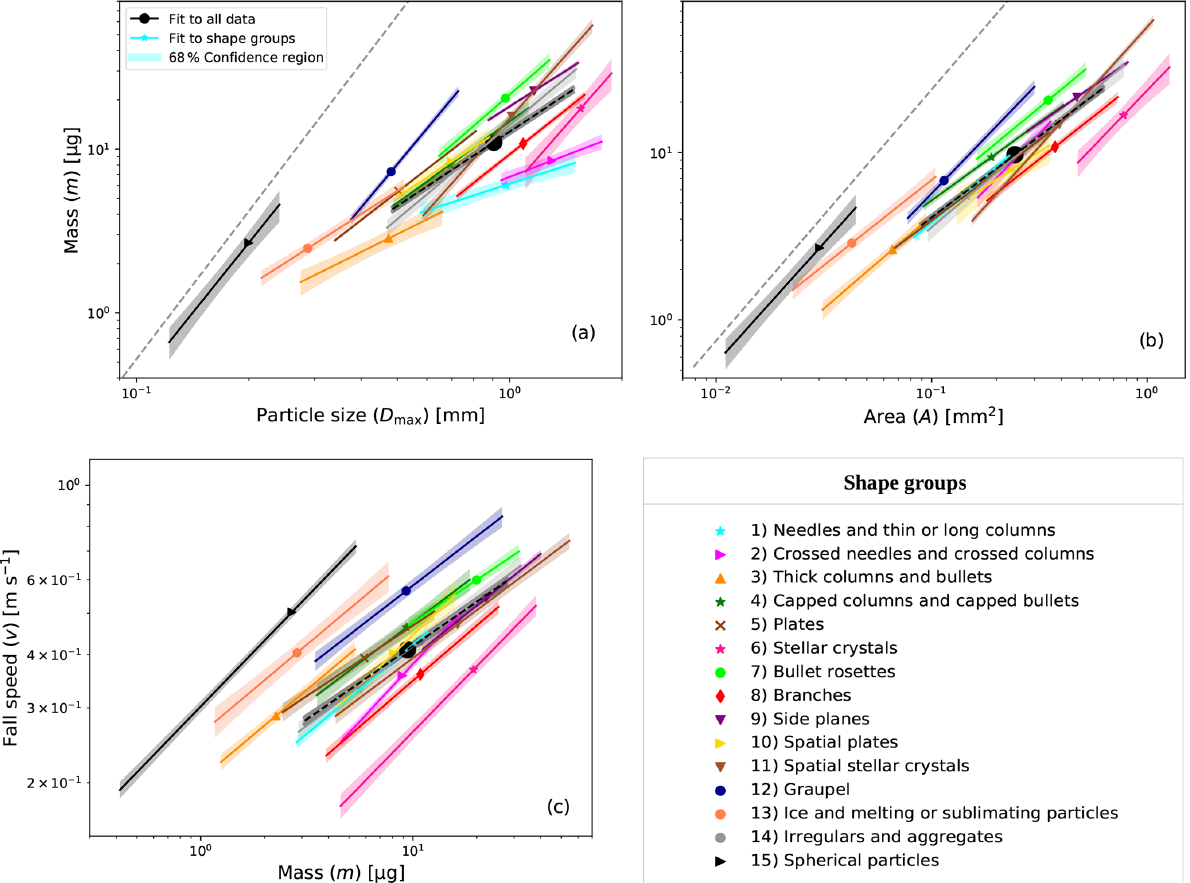
Figure 1. Mass vs. maximum dimension ( m vs. D max ), mass vs. cross-sectional area ( m vs. A ), and fall speed vs. mass ( v vs. m ) relationships are shown in logarithmic scale for all the shape groups (solid lines) and all data (dashed black line). The median D max , A , and m of the data are represented as a single point on each line. The length of fit lines is defined by 16th and 84th percentiles of D max , A , and m . The 68% confidence region for the fits is also shown. (a) The m vs. D max relationships. For comparison, the mass of spheres, corresponding to rain or · ρ w · D 3 = 1gcm − 3 , is shown as a dashed grey line. (b) The m vs. A relationships. fog droplets, given by m = π max , where the density ρ w 6 · ρ w · A 3 / 2 is shown as a dashed grey line. (c) The v vs. m ·√ For comparison, the mass of spheres given by m = 4 π 3